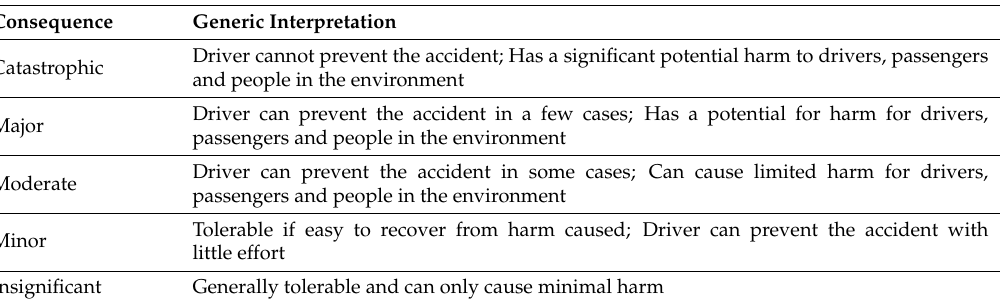
Table 10. Qualitative Consequence Scale for